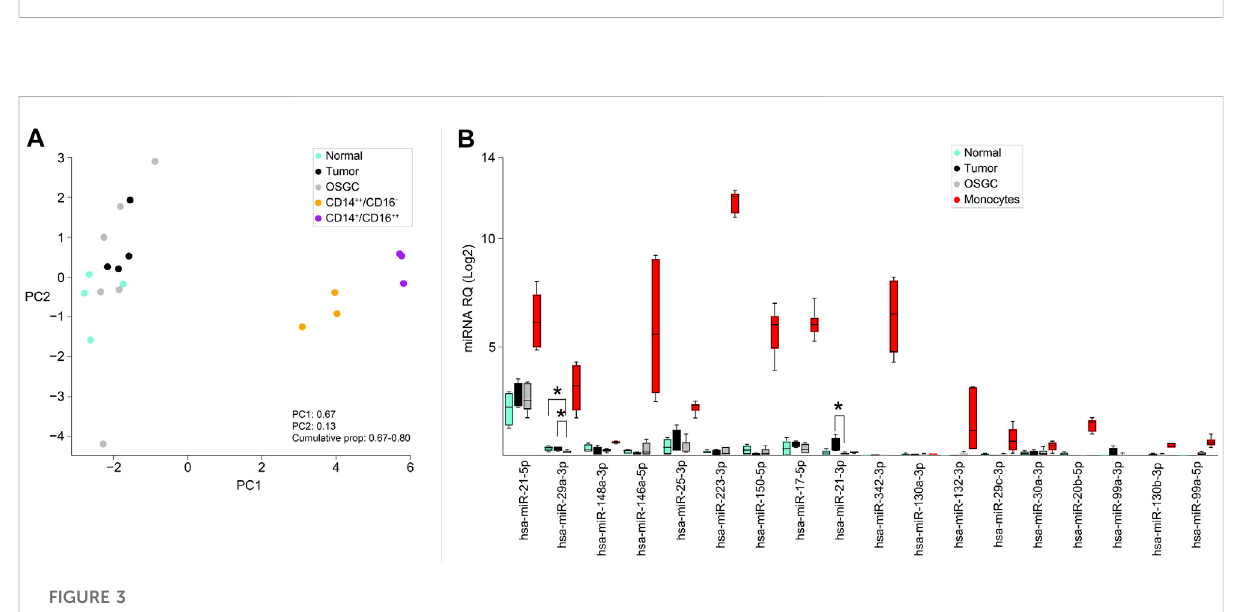
FIGURE 3 Monocyte-related miRNAs expressed in OSGCs. (A) Principal component analysis (PCA), unsupervised analysis of classical (CD14++/CD16 − ) and non-classical (CD14+/CD16++) monocyte subsets clustering separately from the normal breast epithelium, cancer cells, and OSGC. (B) Monocyte-speci fi c miRNAs signature applied to breast samples in which OSGC show differential expression of miR-29a-3p and